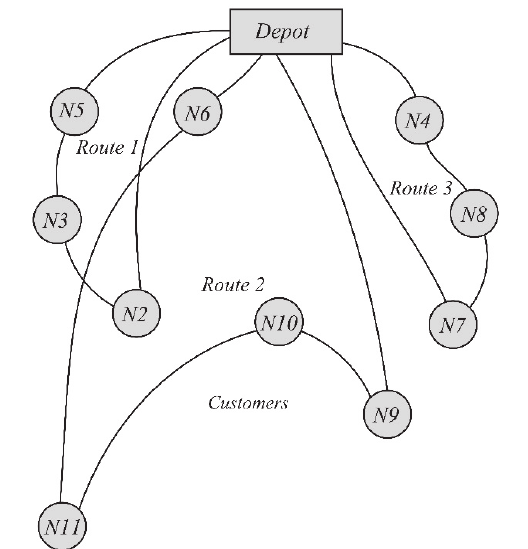
Fig. 1. Solution to a VRP problem with three vehicles and a single